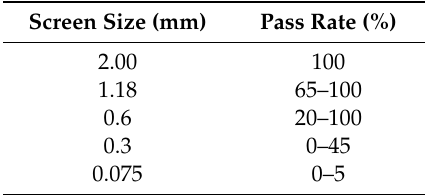
Table 2. CR (crumb rubber) screen